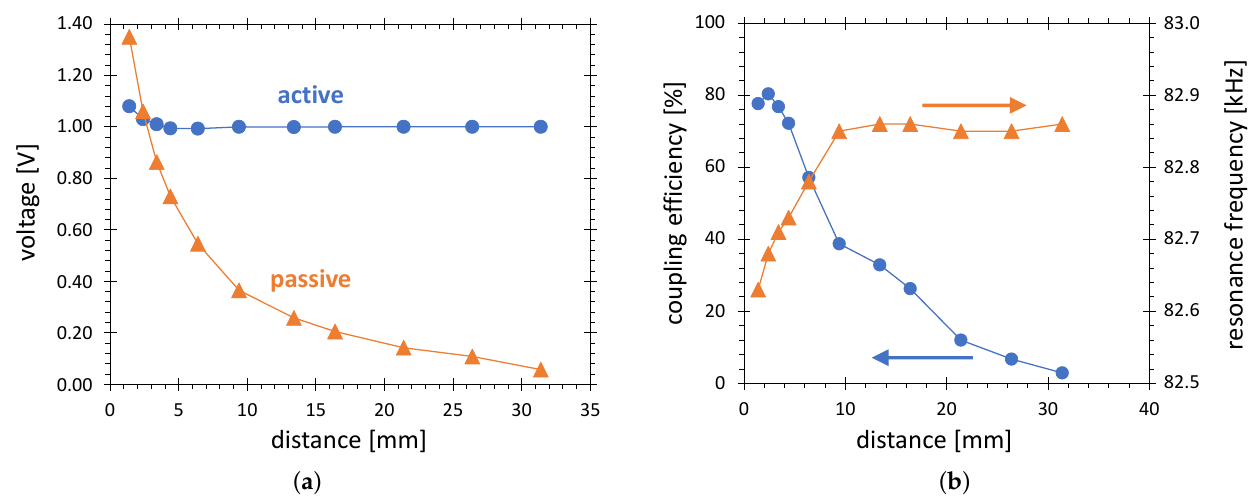
Figure 2. The energy coupling from active to passive PCPG (see Figure 1a) as a function of distance between the PCPG tips. ( a ) Voltages on the low voltage sides of the PCPGs. ( b ) The coupling efficiency and the resonance frequency of the active PCPG determined with 10 k Ω load on the low voltage side of the passive PCPG. Both PCPGs used are of CeraPlas™HF type. The signal on input of the active PCPG was sinusoidal with amplitude of 1 V.